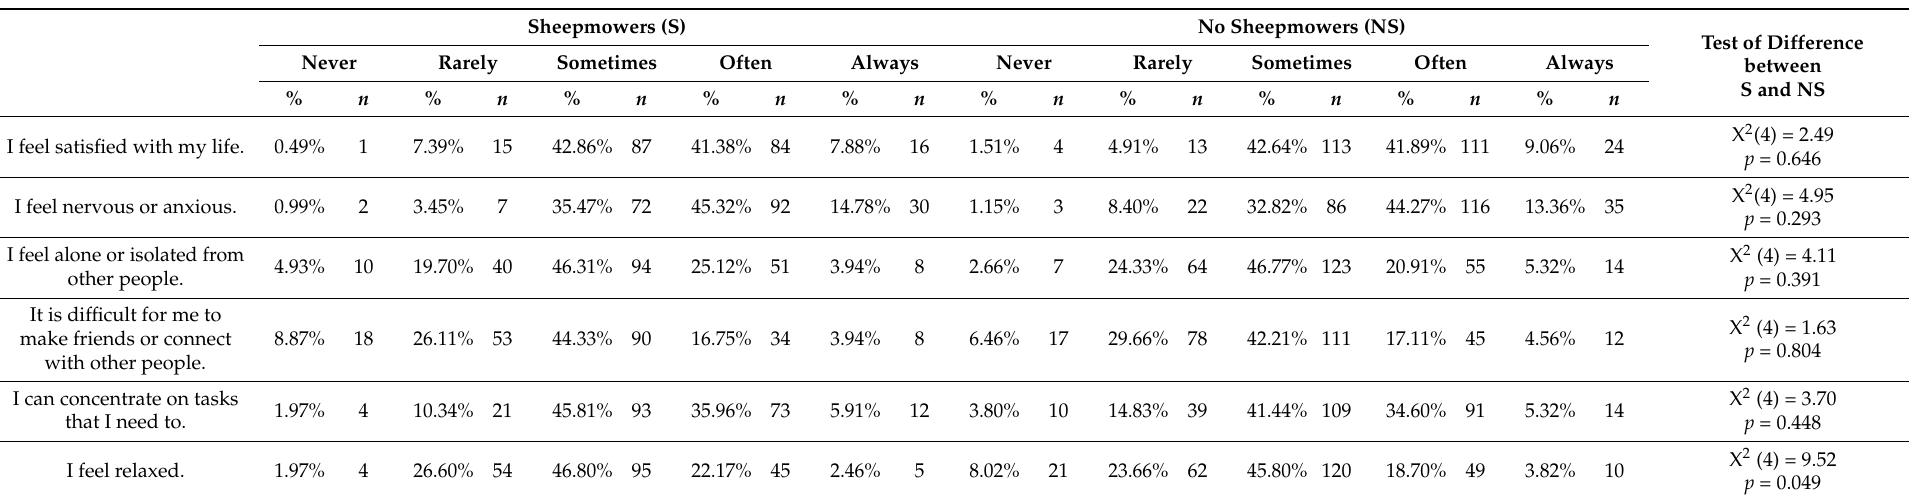
Table 3. Web-based Survey Respondents’ Overall Life